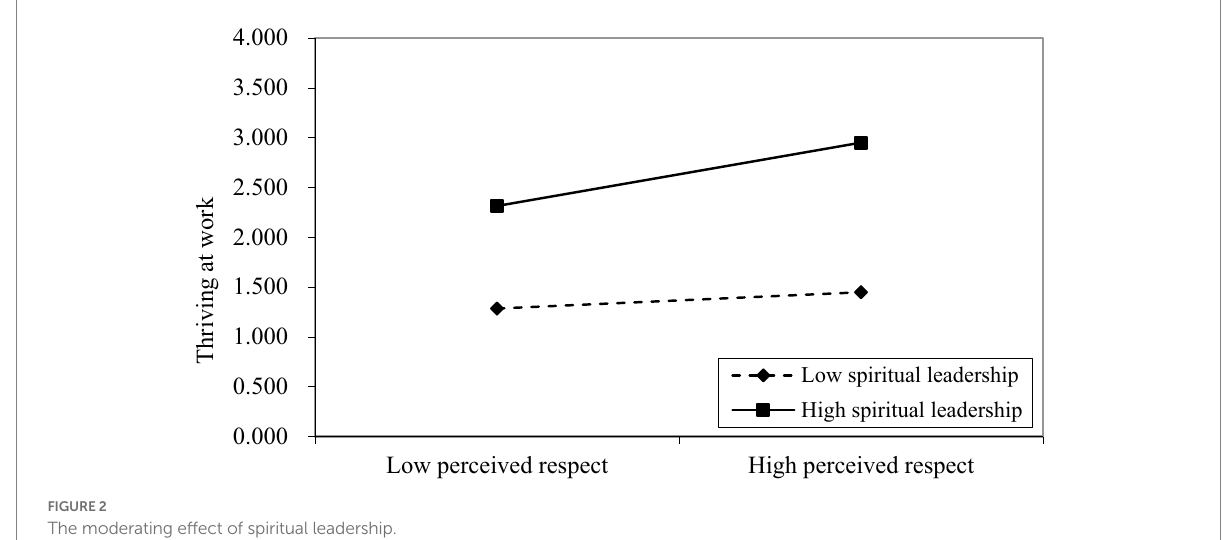
FIGURE 2 The moderating effect of spiritual leadership.